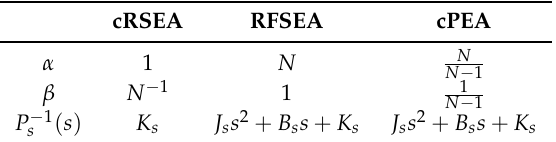
Table 4. Generalized parameters of cRSEA, RFSEA and cPEA.